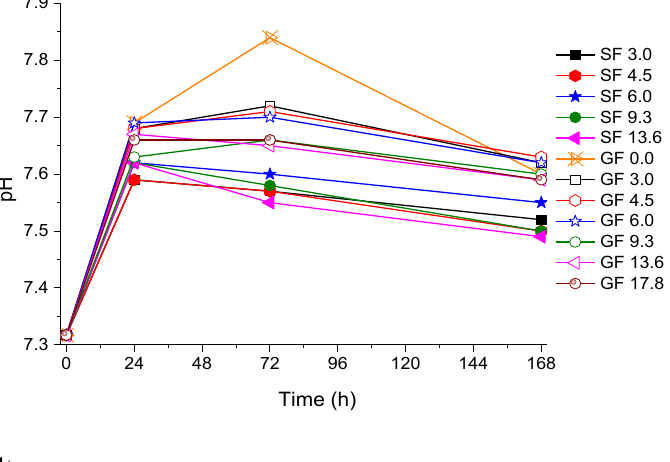
Figure 4. pH measured at the end of the immersion time in Tris buffer. Open symbols are for the CaF series (GF) and closed symbols are for the SrF 2 nominal fluoride